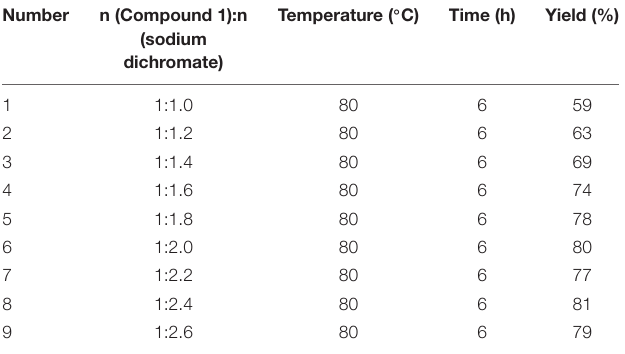
TABLE 1 | Ratio optimization of sodiumdichromate to yield compound 2 .